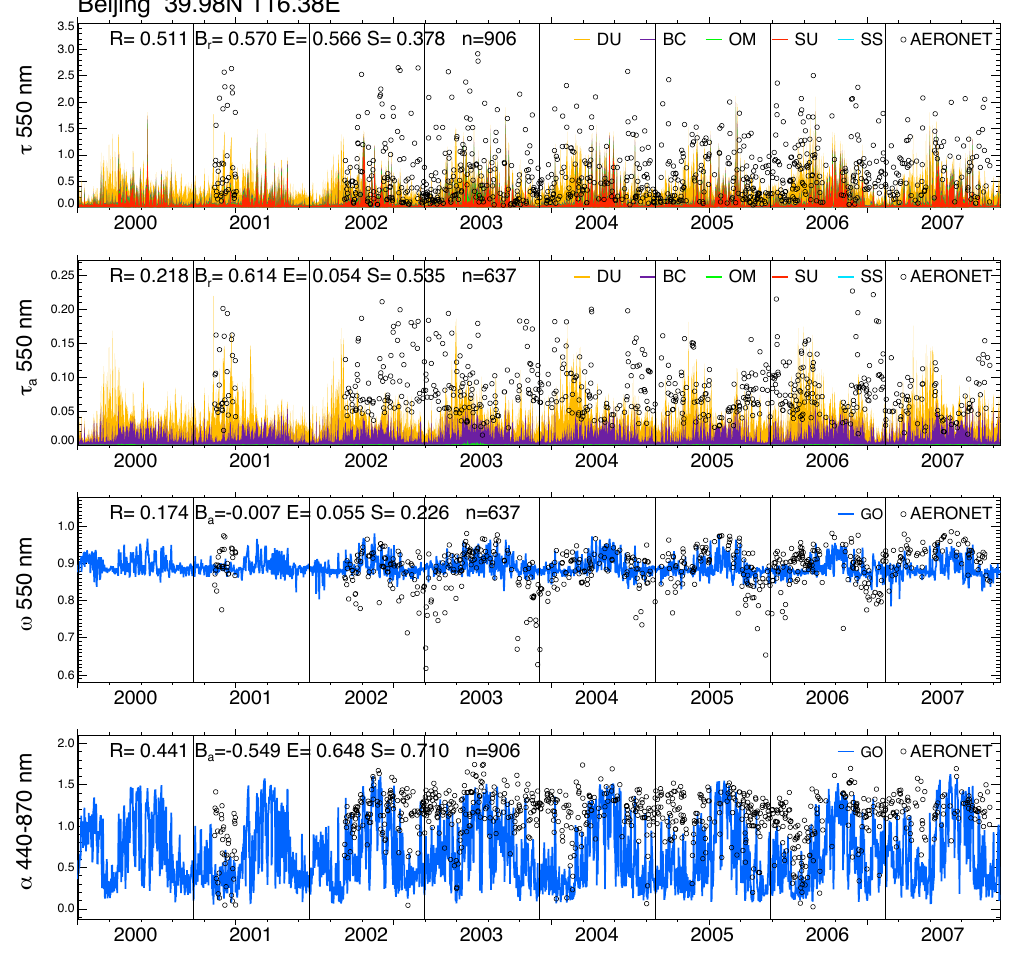
Fig. 5d. Same as Fig. 5a but for Beijing,